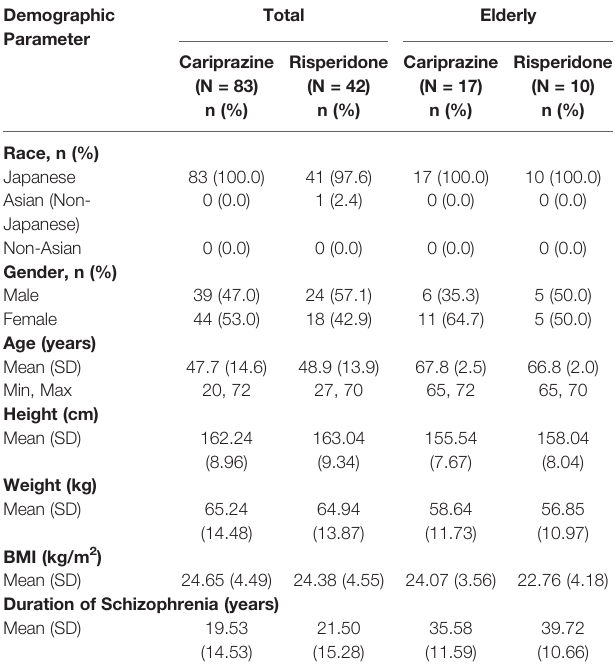
TABLE 5 | Demographics and other baseline characteristics (Safety Analysis Population, A002-07). Demographic